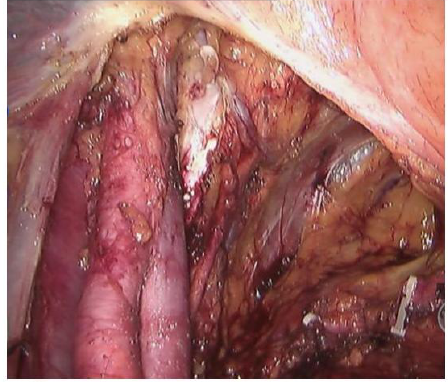
FIGURE 3. Obturator